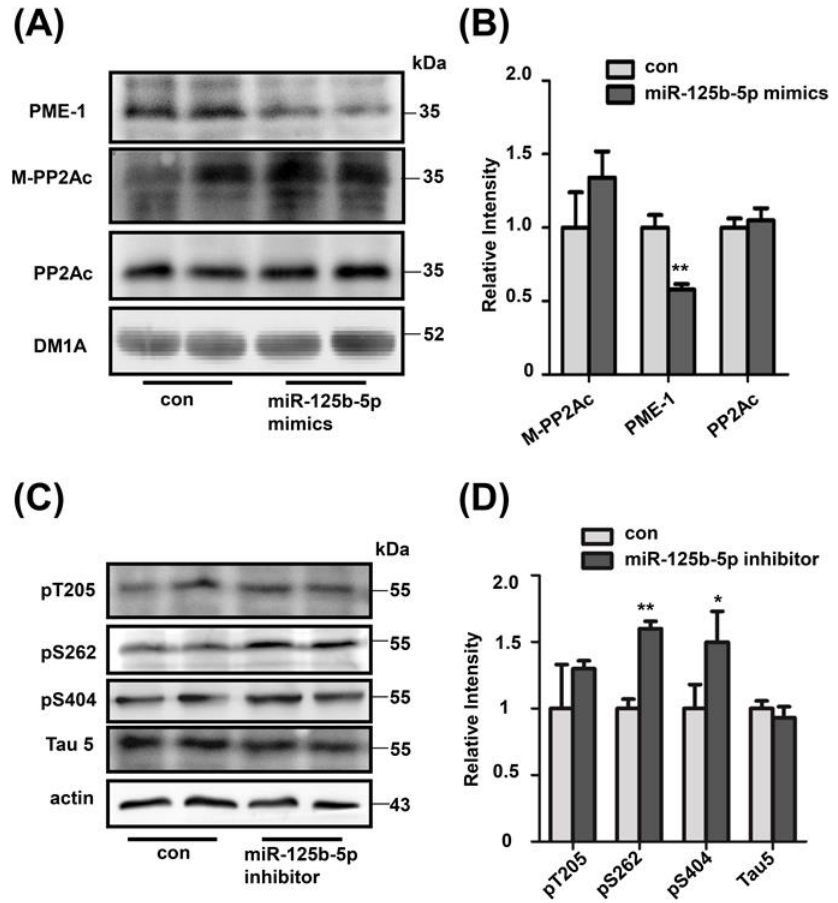
Figure 6. Low expression of miR-125b-5p induces tau hyperphosphorylation by removing the inhibition of PME-1 translation. ( A ) Western blotting of PME-1, m-PP2Ac and PP2Ac. ( B ) Relative intensity of PME-1, m-PP2Ac and PP2Ac. ( C ) Western blotting of pT205, pS262, pS404 and tau 5. ( D ) Relative intensity of pT205, pS262, pS404 and tau 5. * p < 0.05, compared with C3H; ** p < 0.01, compared with C3H. Data are presented as means ± SD.